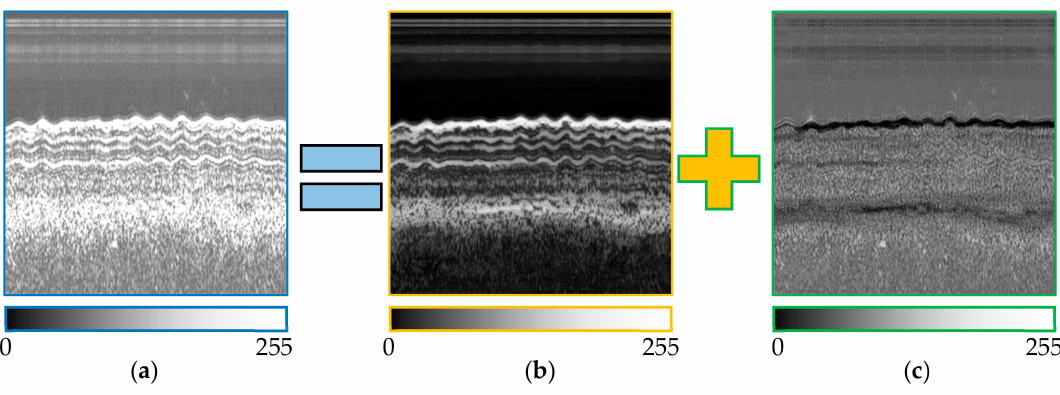
Figure 8. Noise separation of SBP image with the non-local low-rank algorithm. ( a ) Waterfall image disturbed by noise; ( b ) de-noised image; ( c ) noise image.